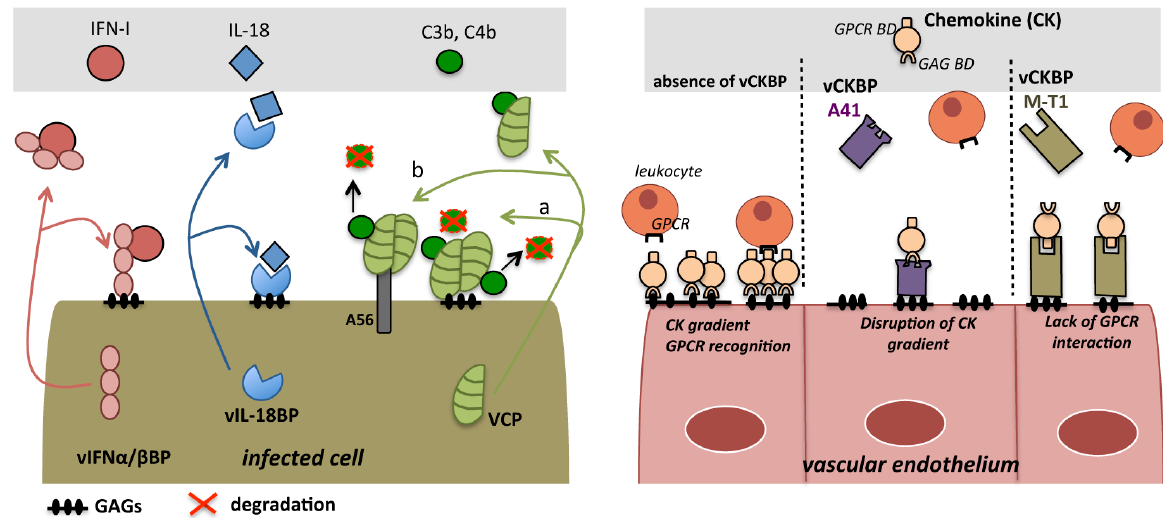
Figure 1. Poxvirus secreted immunomodulators function at the cell surface. Viral IL-18-binding protein (vIL-18BP) and viral IFN-I-binding protein (vIFN α / β BP) are secreted from infected cells and bind their respective ligands either as a soluble form or anchored to the cell surface through glycosaminoglycan (GAG) interactions, acting in both cases as cytokine decoy receptors. Vaccinia virus complement control protein (VCP) retention at the cell surface is mediated by either GAGs (a) or the viral protein A56 (b) and binds regulatory complement proteins promoting their inactivation. A41 and M-T1 viral chemokine-binding proteins (vCKBPs) are anchored to the surface of endothelium by interacting with GAGs and simultaneously bind chemokines. A41 interacts with the chemokine GAG-binding domain (GAG BD) to